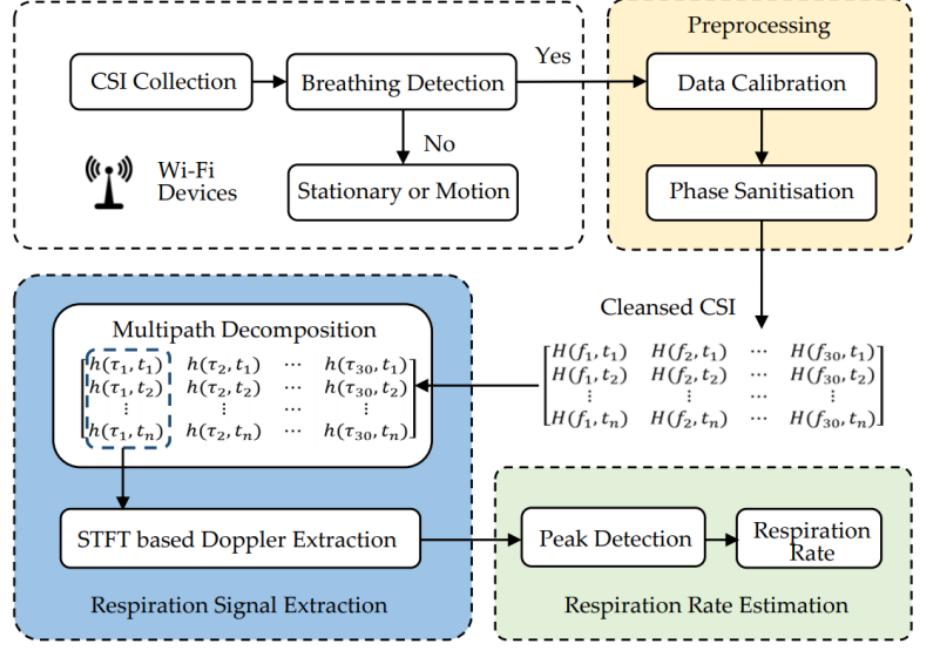
Figure 4. System